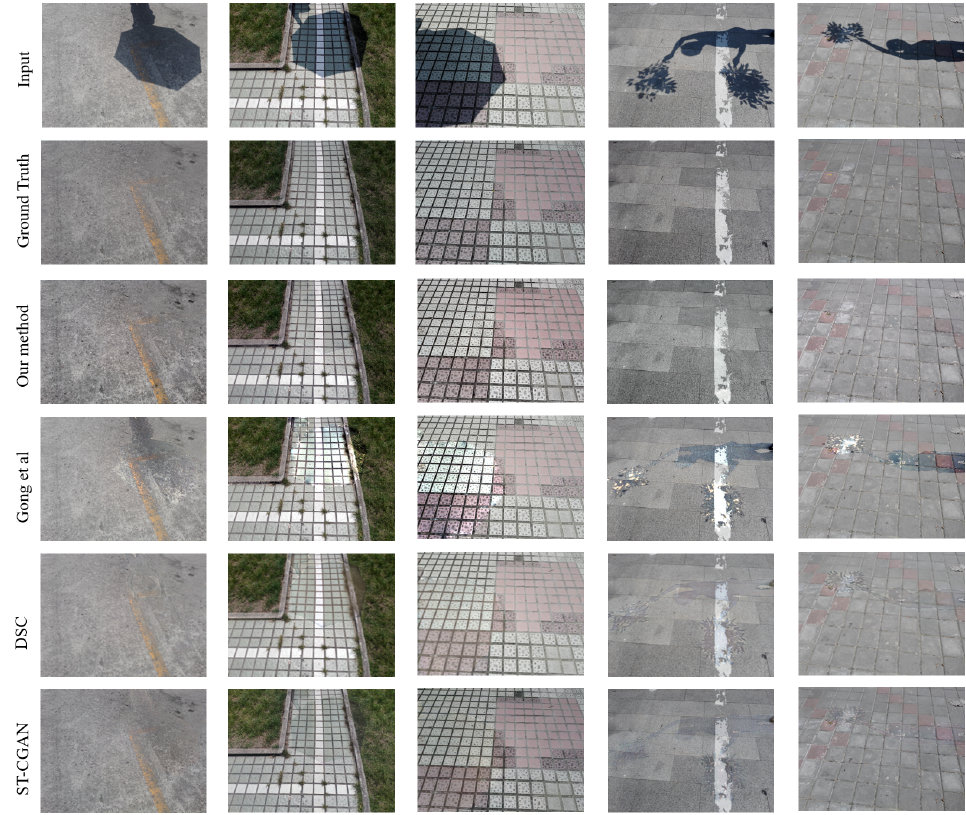
Figure 7. Visualization results of different methods. From top to bottom: shadowed image (input), the ground truth, our method, Gong et al. [37], DSC [7] and ST-CGAN [9]. Nearly all shadows are removed by our method. Furthermore, the color, brightness, and texture are more similar to the ground